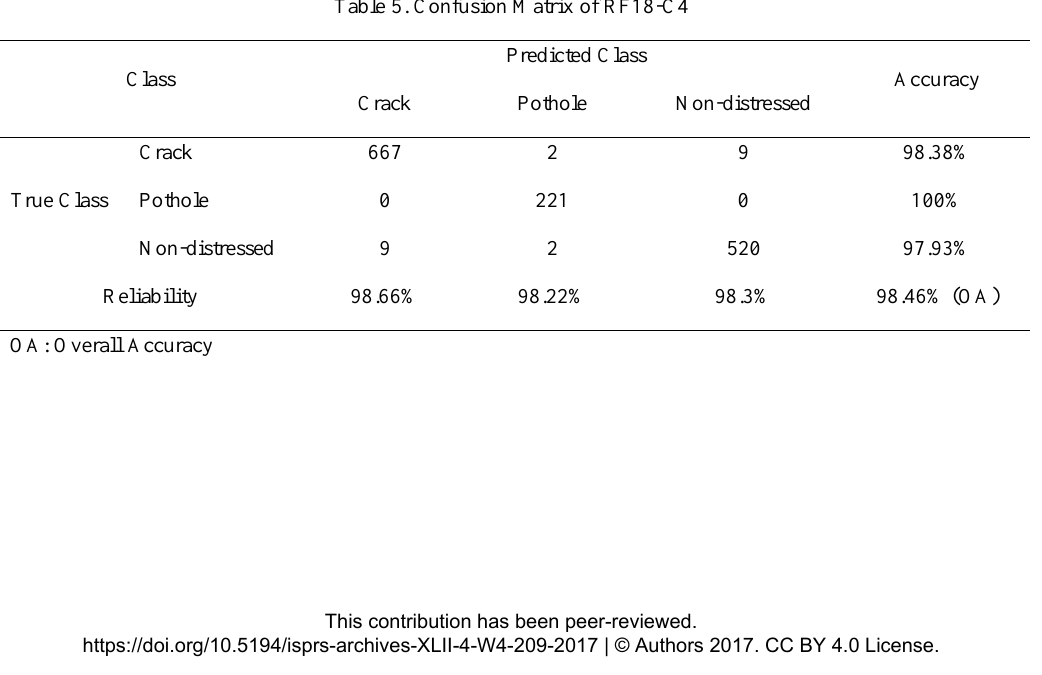
Table 5. Confusion Matrix of